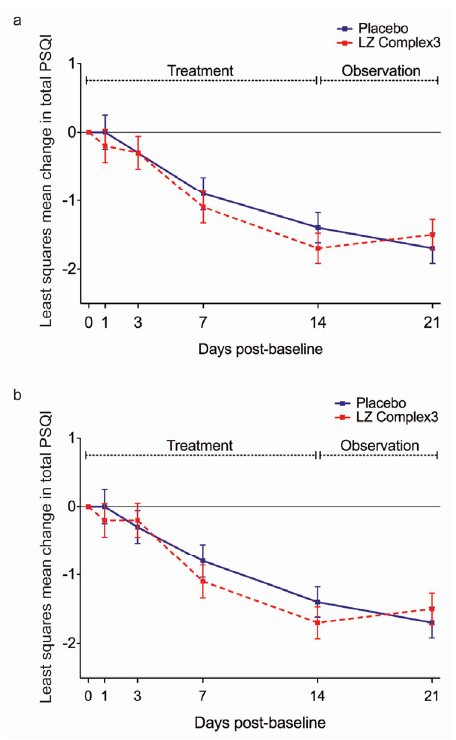
Figure 3. Least squares mean change in total Pittsburgh Sleep Quality Index (PSQI) between baseline (day 0) and end of the observation period (day 21) by treatment group in: ( a ) the modified intention-to-treat (mITT) population and ( b ) the per protocol (PP) population. Table 4. Total PSQI, mean (SD).